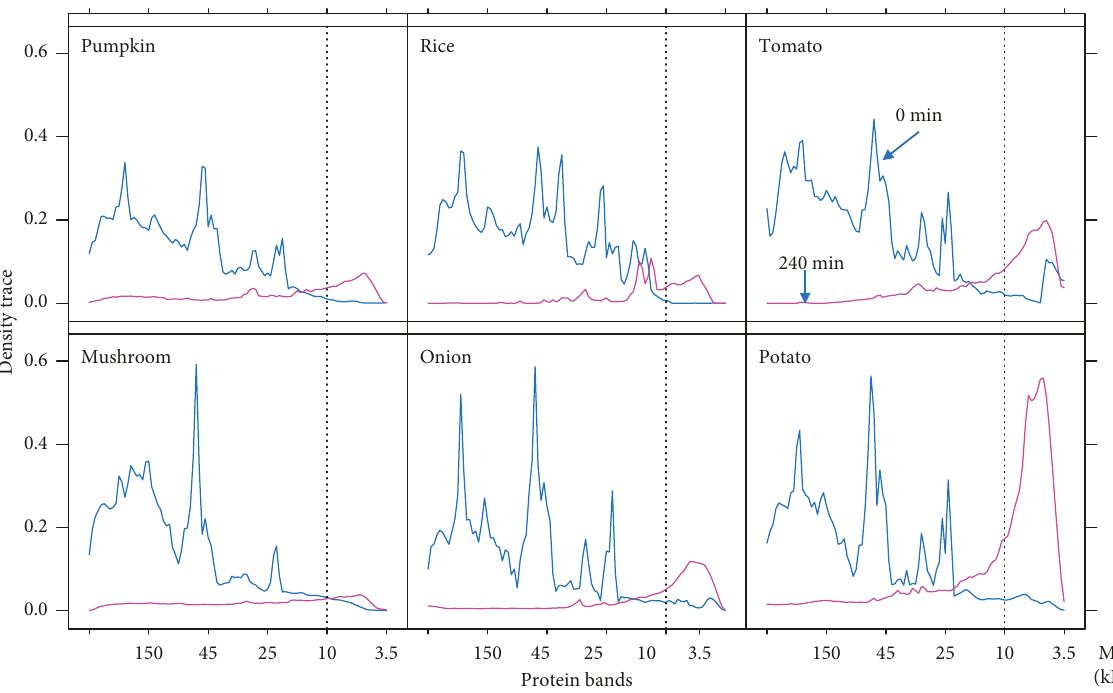
Figure 9: Experiment 5: density tracings of SDS PAGE showing the effect of vegetable accompaniments in a cooked “meal” containing semimembranosus from cow, bull, or calf on the digestibility of total proteins. Results at T0 of gastric phase and T240 of intestinal phase for meals containing pooled bull meat from Experiment 1 with six accompaniments are presented as